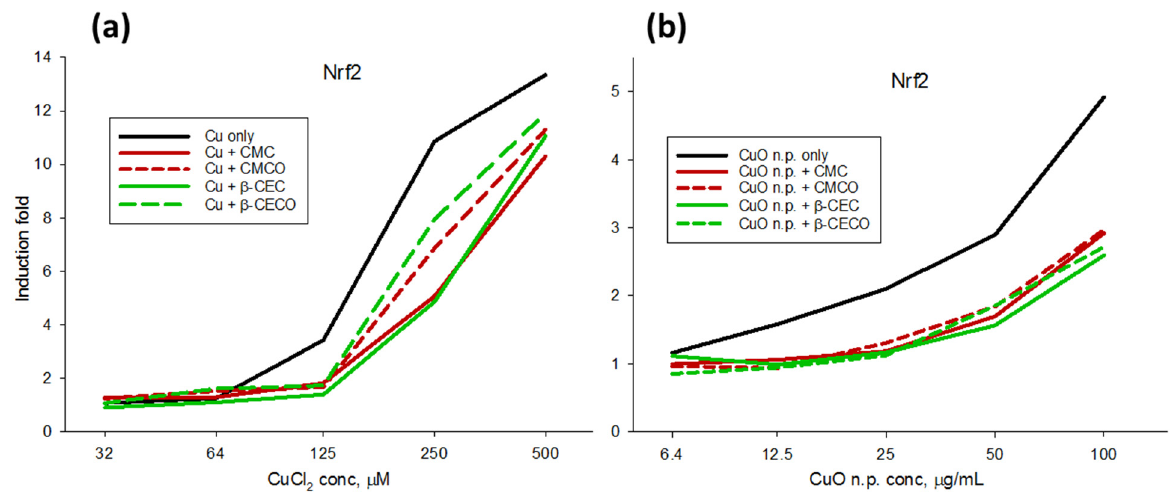
Figure 10. Activation of the antioxidant pathway in NRK-52E cells treated with ( a ) CuCl 2 , ( b ) CuO nanoparticles (30–50 nm), and co-treated with 1 mM S -carboxyalkylcysteines for 18